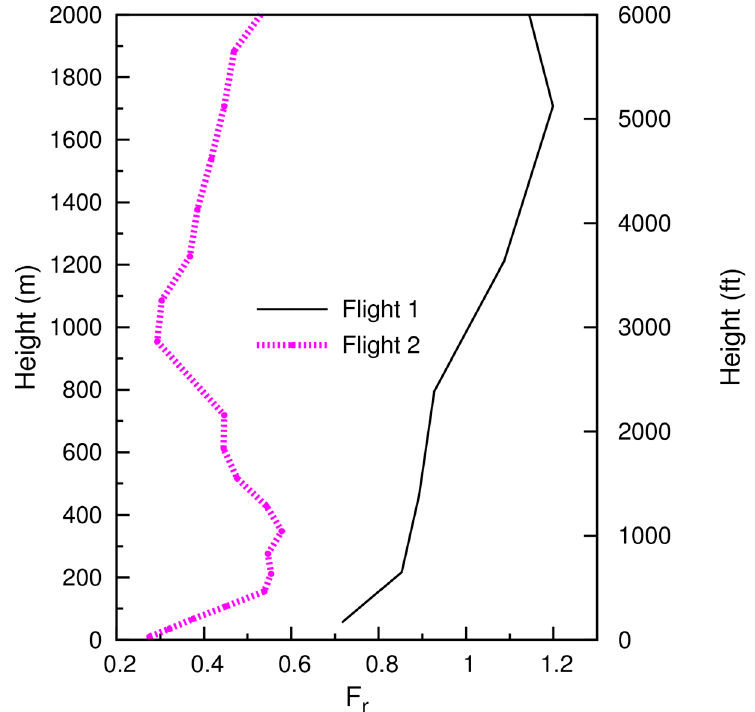
Figure 7. Vertical profile of Froude number (from AROME forecasts) for both flights.